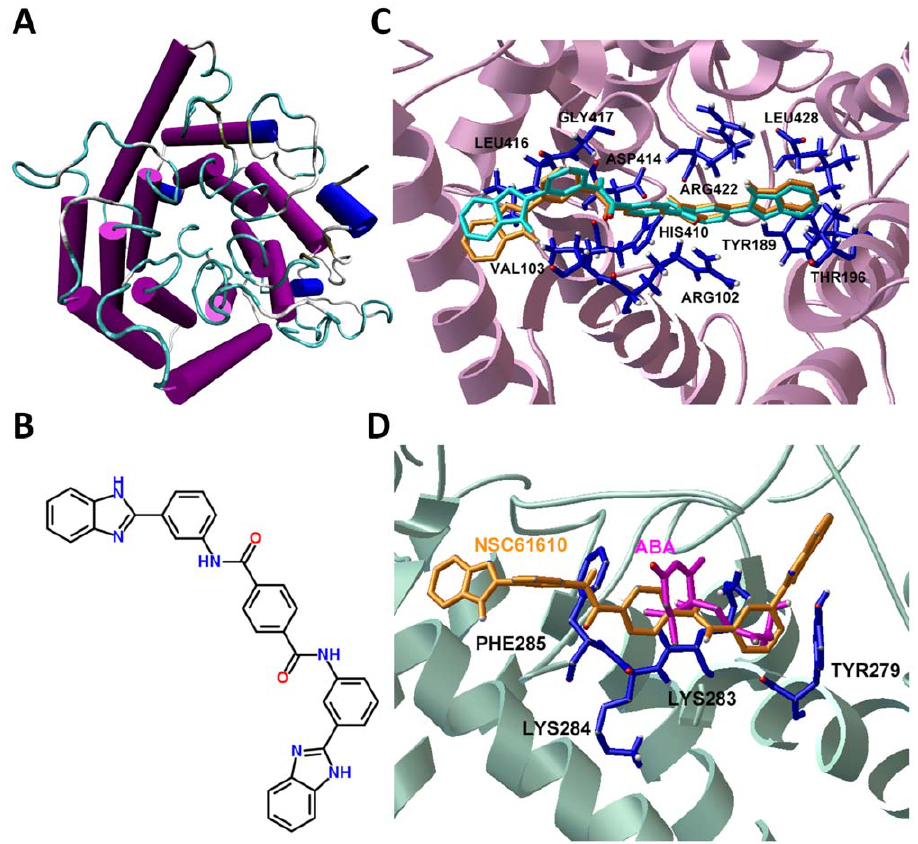
Figure 1. Lanthionine synthetase C-like 2 (LANCL2) and NSC61610 insilico . (A) The homology model of human LANCL2 is shown in Cartoon representation with coloring according to secondary structure. Purple: alpha helix; Blue: other helix; Yellow: bridge_beta; Cyan: turn; Green: coil. (B) 2- D structure of NSC61610. (C) Representative binding mode of the most stable docked orientation of NSC61610 with LANCL2. The LANCL2 model is shown in ribbon mode. NSC61610 pose generated by AutoDock Vina is colored in cyan and the one generated by AutoDock is colored in orange. Selected residues of LANCL2 (blue) are depicted by stick-and-ball models and colored by atom types. Amino acid residues surrounding NSC61610 are labeled. (D) Representative binding modes of the docked orientation of abscisic acid (ABA) and NSC61610 with LANCL2. LANCL2 is shown in a ribbon mode. NSC61610 (orange) and ABA (magenta) are shown in stick-and-ball model. Selected residues of LANCL2 surrounding both NSC61610 and ABA are depicted by stick-and-ball model and labeled. The images were rendered in Visual Molecular Dynamics